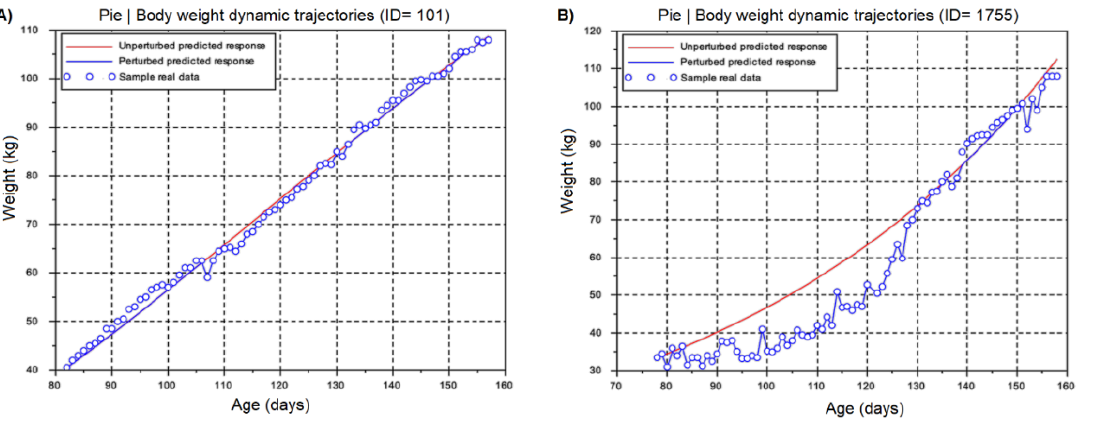
Figure 2 . Comparison of the perturbed (blue line) and the unperturbed (red line) predicted response based on the body weight dynamic trajectories recorded during the whole fattening period.